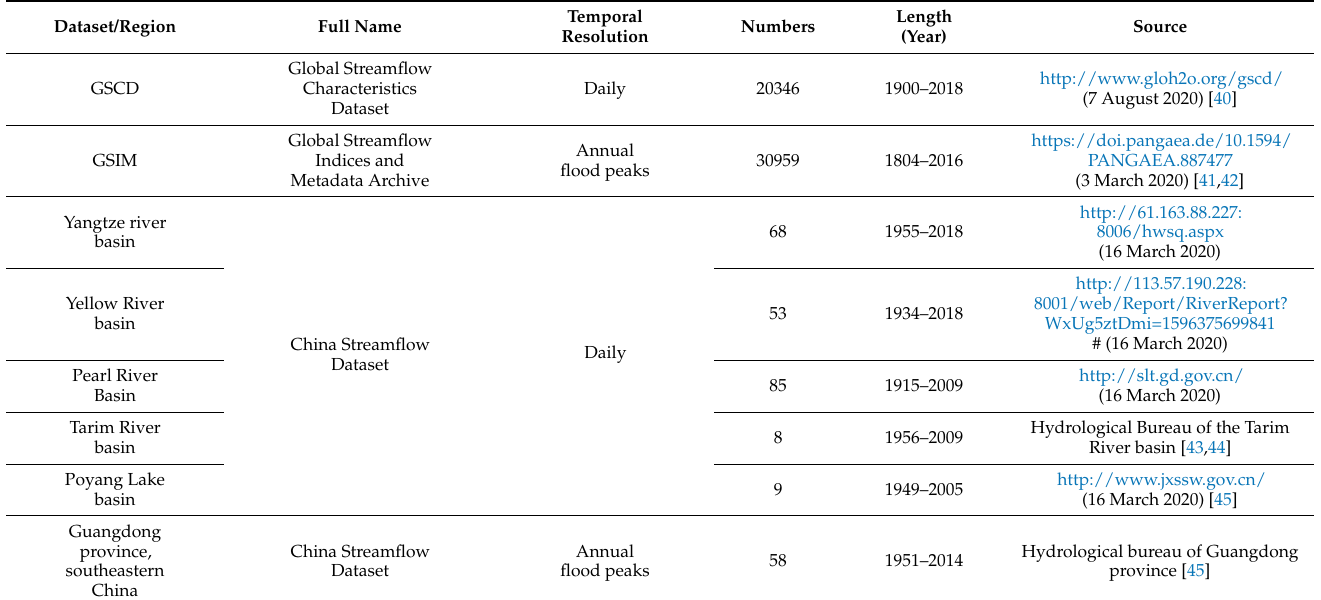
Table 1. Details of streamflow datasets collected in this